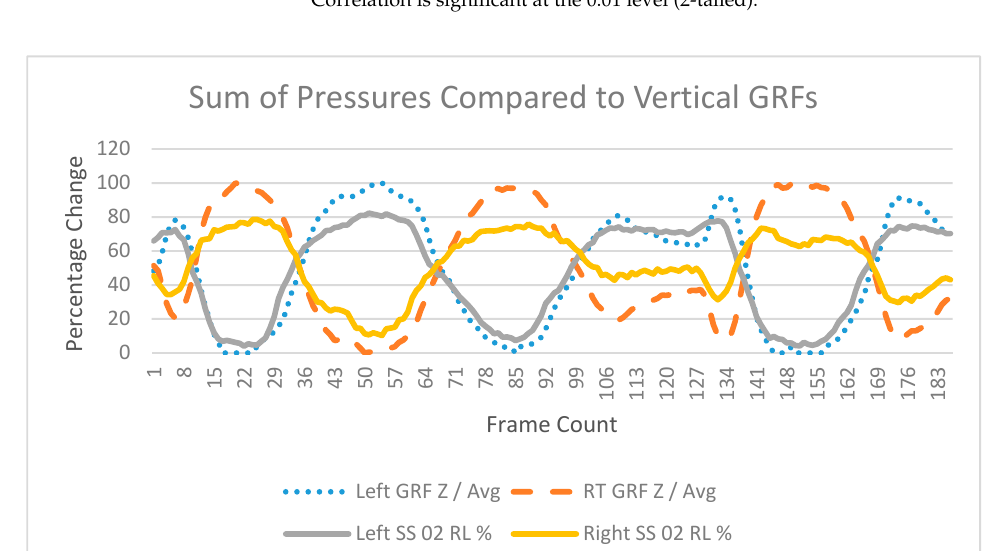
Figure 5. Comparison of C-SRSs to ground reaction forces during shifting of right to left with sensors in M / L orientation. The vertical axis represents percentage of change over horizontal axis of time. The blue line represents the sum of pressures percentage changes in the left foot C-SRSs. The grey line represents the vertical (Z-axis) GRFs from the left Kistler TN Force Plate. The orange line represents the sum of pressures percentage changes in the right foot C-SRSs. The yellow line represents the vertical (Z-axis) GRFs from the right Kistler TM Force Plate.